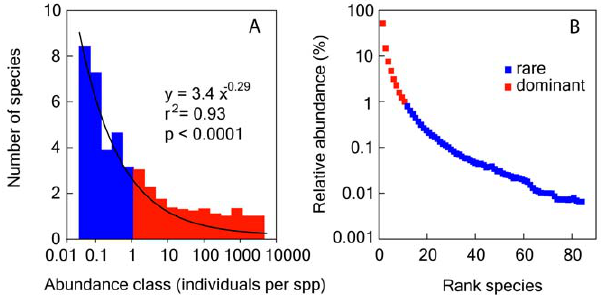
Figure 3. Abundance-dominance curves for marine phyto- plankton. A. Preston’s representation showing the number of species as a function of population abundance across logarithmic size classes. Black line is the best fit to data. B. Number of individuals versus taxon, with taxa ranked according to their respective abundance. Red and blue squares represent dominant and rare species, respectively. Data from Atlantic Meridional Transect 1–4 were used in these analyses (see Methods for details).